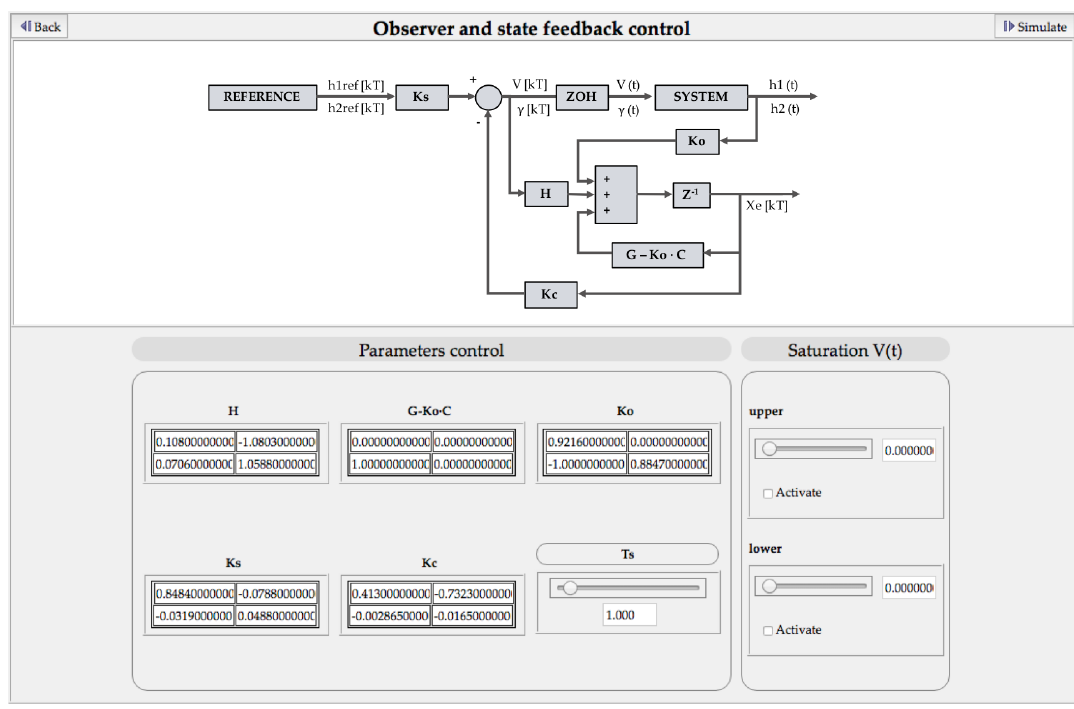
Figure 6. Configuration of the control